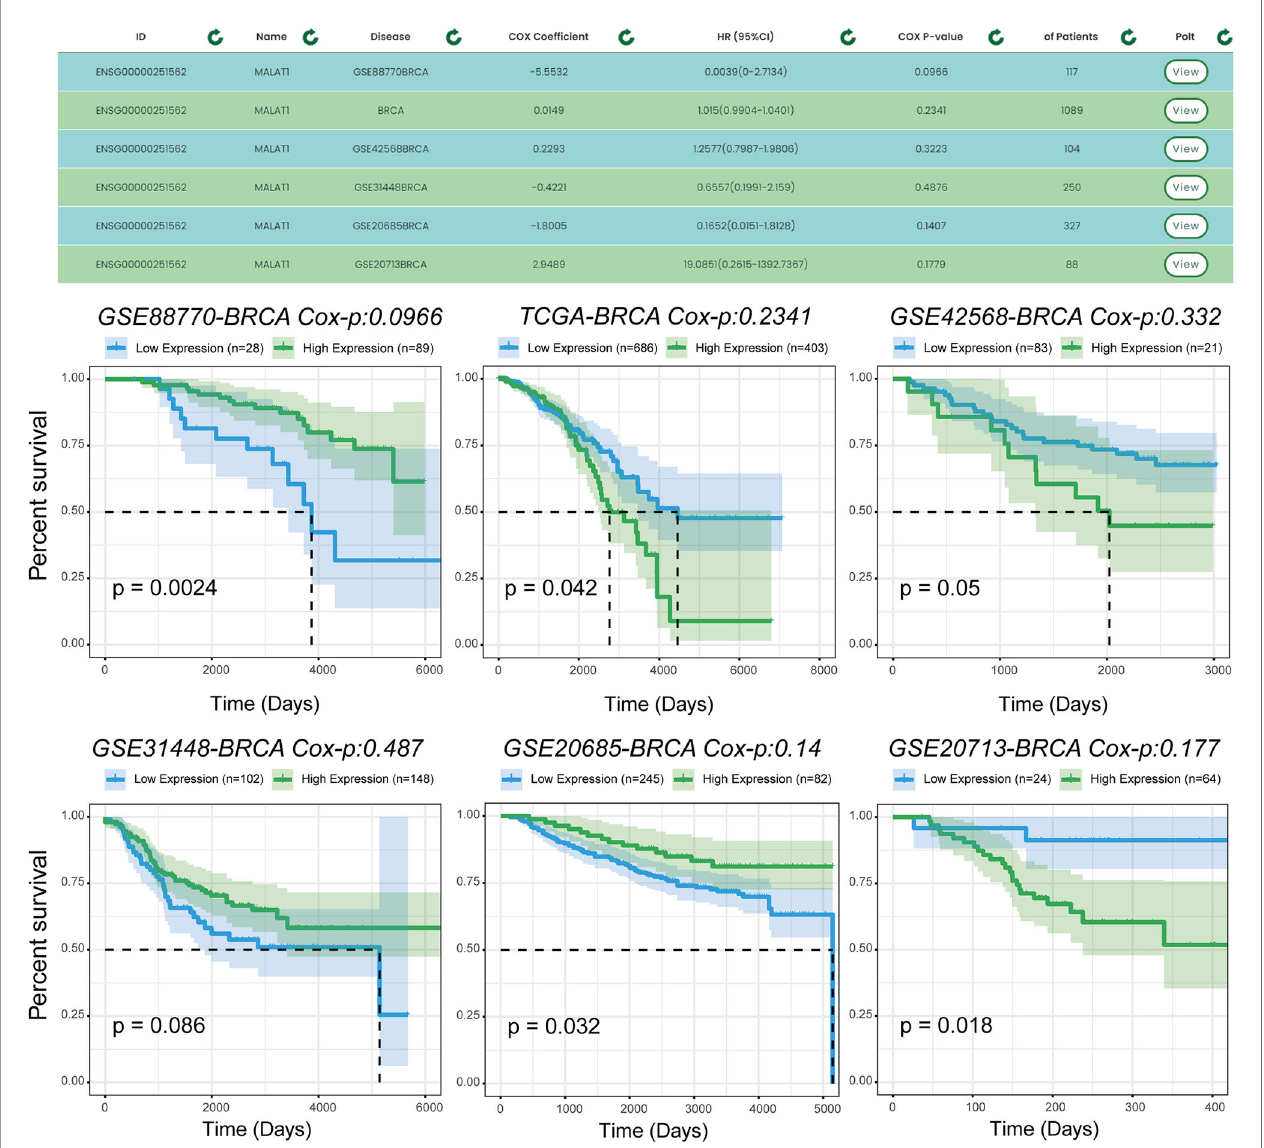
FIGURE 5 | Prognostic analysis of MALAT1 in multiple data sets. MALAT1 shows different prognoses in different datasets of the same cancer, and users can use the results to make comprehensive and objective